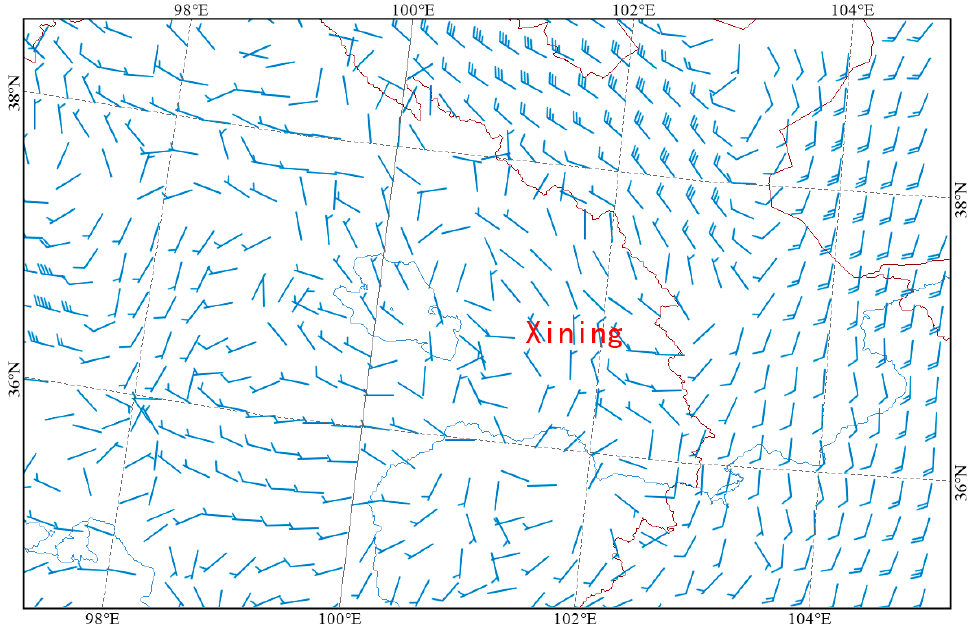
Figure 1. One of the 700 hPa wind fields of ECMWF fine grid prediction products (the spatial resolution was 0.25° × 0.25°).